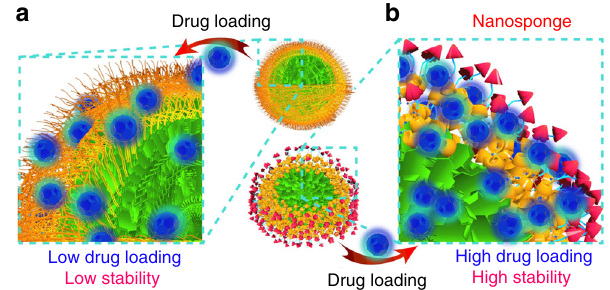
Fig. 4 Schematic illustration of drug encapsulation. Schematic comparison of drug loading ef fi ciency and stability between a NPs and b SCNPs formed from PDI-PCL- b -PEG-Mal and polyrotaxane,